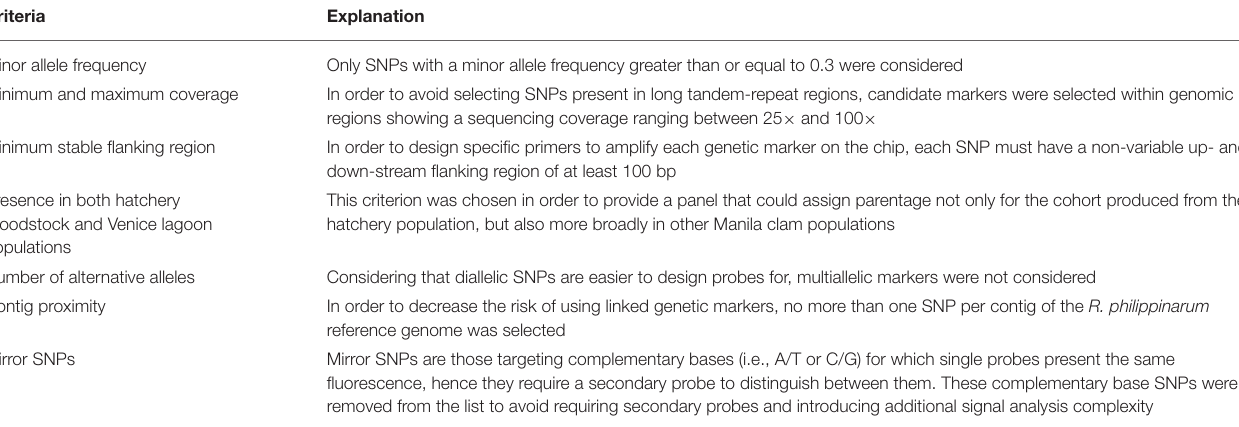
TABLE 2 | Criteria for SNP filtering to select candidate SNPs.